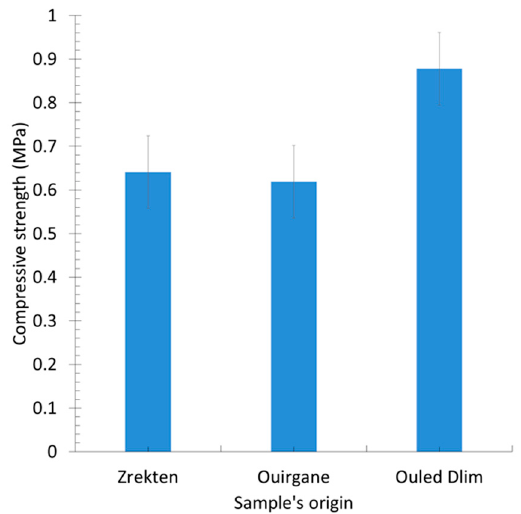
Figure 6. Compressive strength results for the studied soils.